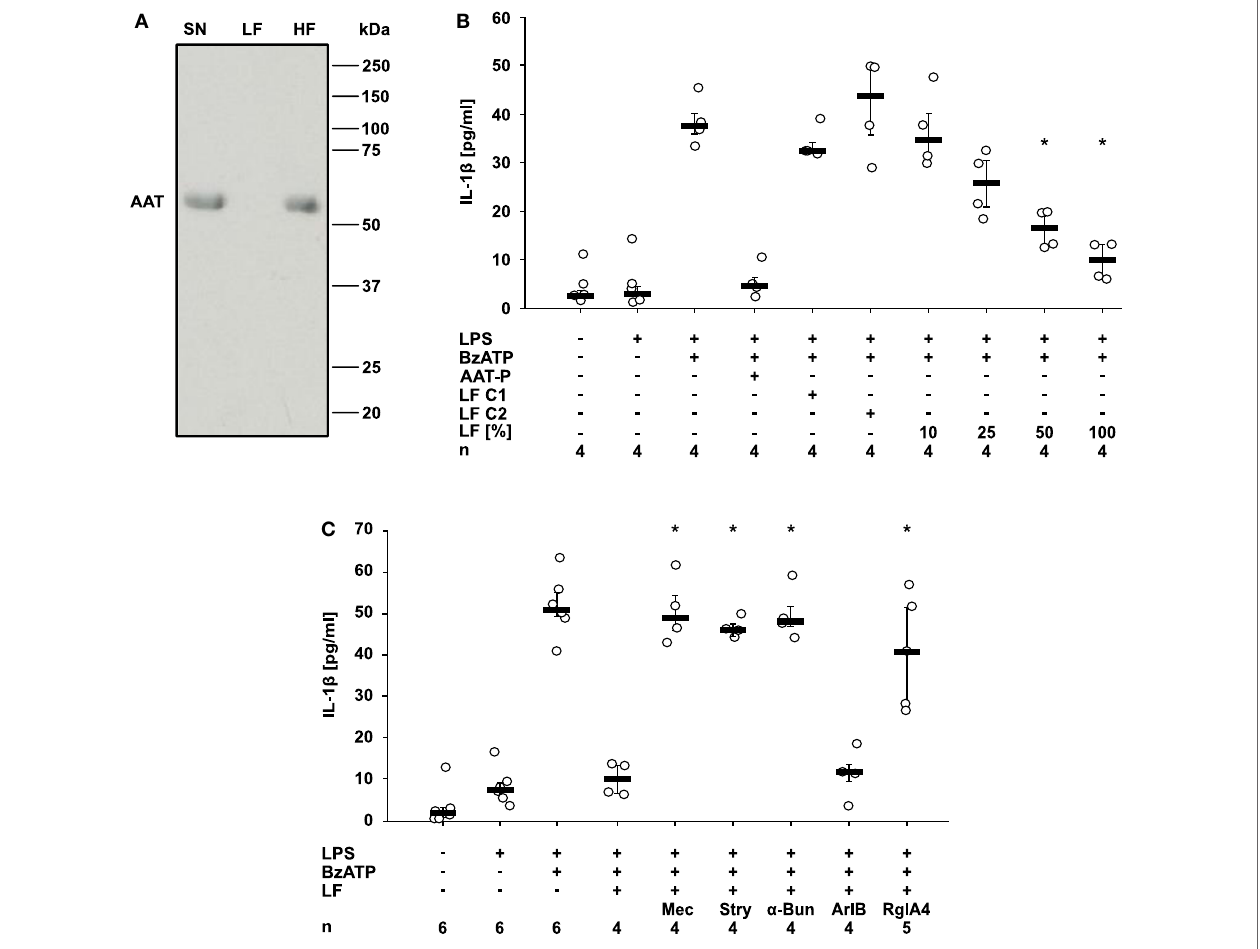
FigUre 6 | Alpha-1 antitrypsin (AAT) induces the release of a bioactive factor. U937 cells were primed with lipopolysaccharide (LPS) and stimulated with Prolastin ® (AAT-P 1 mg/ml) for 30 min before collection of the cell-free cell culture supernatant (SN). A low molecular mass fraction (LF) and a high molecular mass fraction (HF) of the cell culture supernatant were separated by ultrafiltration with a cut-off of 10 kDa. For the production of control LF, either no AAT-P was added to LPS-primed U937 cells (LF C1) or AAT-P was added to the cell-free cell culture supernatant (LF C2) shortly before ultrafiltration. (a) The SN, the LF, and the HF were separated in a 15% SDS-polyacrylamide gel along with a molecular mass marker followed by staining with Brilliant Blue. Bands with a molecular mass of about 52 kDa correspond to AAT. (B,c) LPS-primed U937 cells were stimulated with 2 ′ (3 ′ )- O -(4-Benzoylbenzoyl)adenosine-5 ′ -triphosphate (BzATP) in the presence or absence of AAT-P. The experiments were performed in medium, LF C1, LF C2, or in different concentrations of LF diluted in medium. Interleukin (IL)-1 β released to the supernatant was measured after 30 min. (c) Nicotinic receptor antagonists mecamylamine (Mec), α -bungarotoxin ( α -Bun), strychnine (Stry), RgIA4, or ArIB [V11L, V16D] were added together with BzATP in the presence of LF. * p ≤ 0.05 versus cells treated with LPS, BzATP, and AAT-P (B) or LF (c) . Data are presented as individual data points, bar represents median, whiskers encompass the 25th to 75th percentile, n -numbers of independent experiments are indicated in the